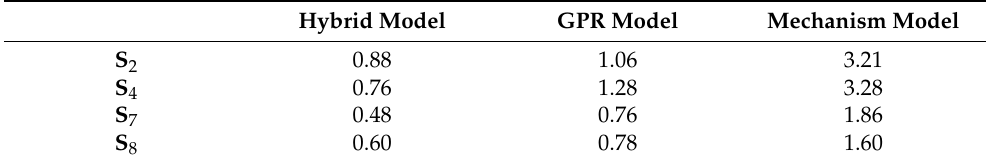
Figure 9. ( a ) The hybrid model, the GPR model and the mechanism model prediction results and relative error of the test set S 2 ( b ) The hybrid model, the GPR model and the mechanism model prediction results and relative error of the test set S 4 ( c ) The hybrid model, the GPR model and the mechanism model prediction results and relative error of the test set S 7 ( d ) The hybrid model, the GPR model and the mechanism model prediction results and relative error of the test set S 8 . Table 3. The RMSE values of the hybrid, GPR, and mechanism models of test sets S 2 , S 4 , S 7 , S 8 .